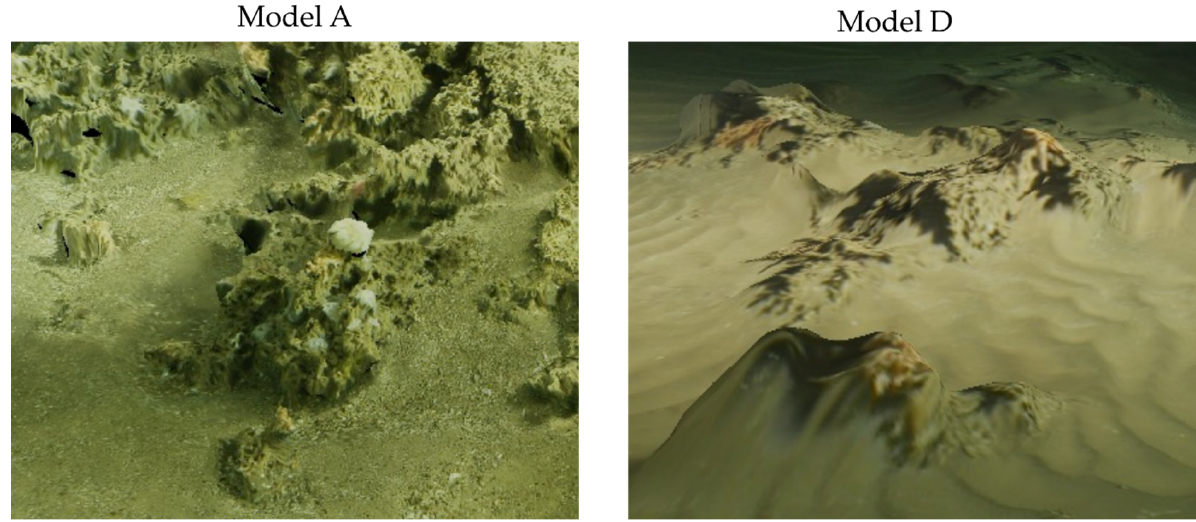
Figure 7 . View of Model A (297,749.21 faces/m2 resolution) and Model D (4,108.31 faces/m2 resolution) from Unity 3D desktop. Here, it is possible to see the resolution differences between models.